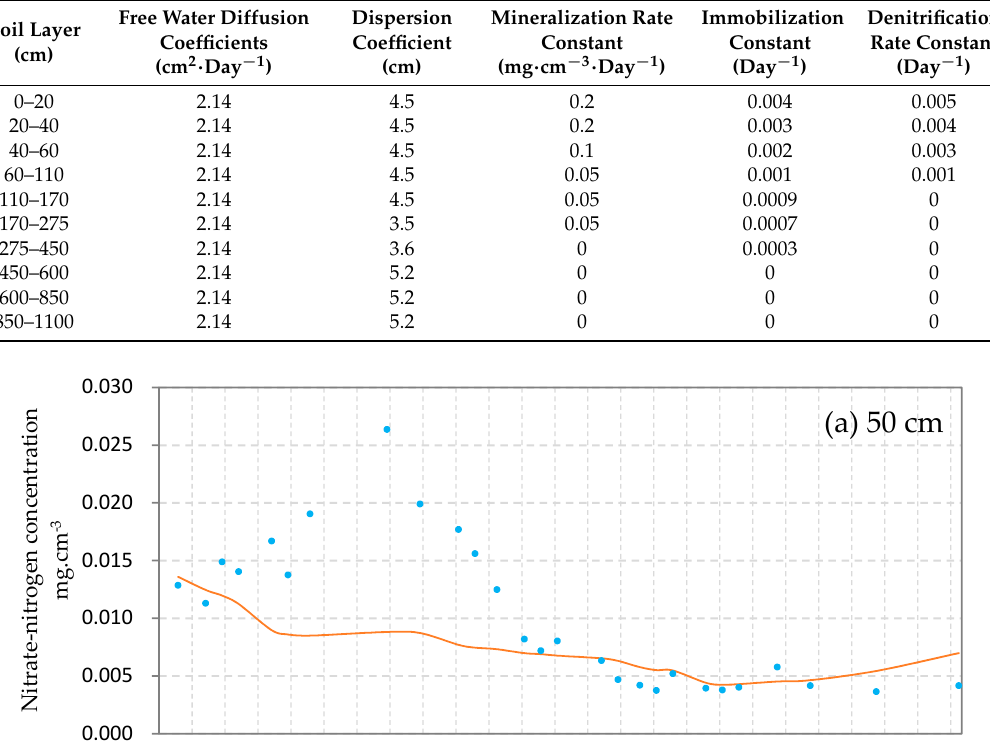
Table 3. Soil nitrate nitrogen transportation and transformation parameters. Soil Layer (cm)